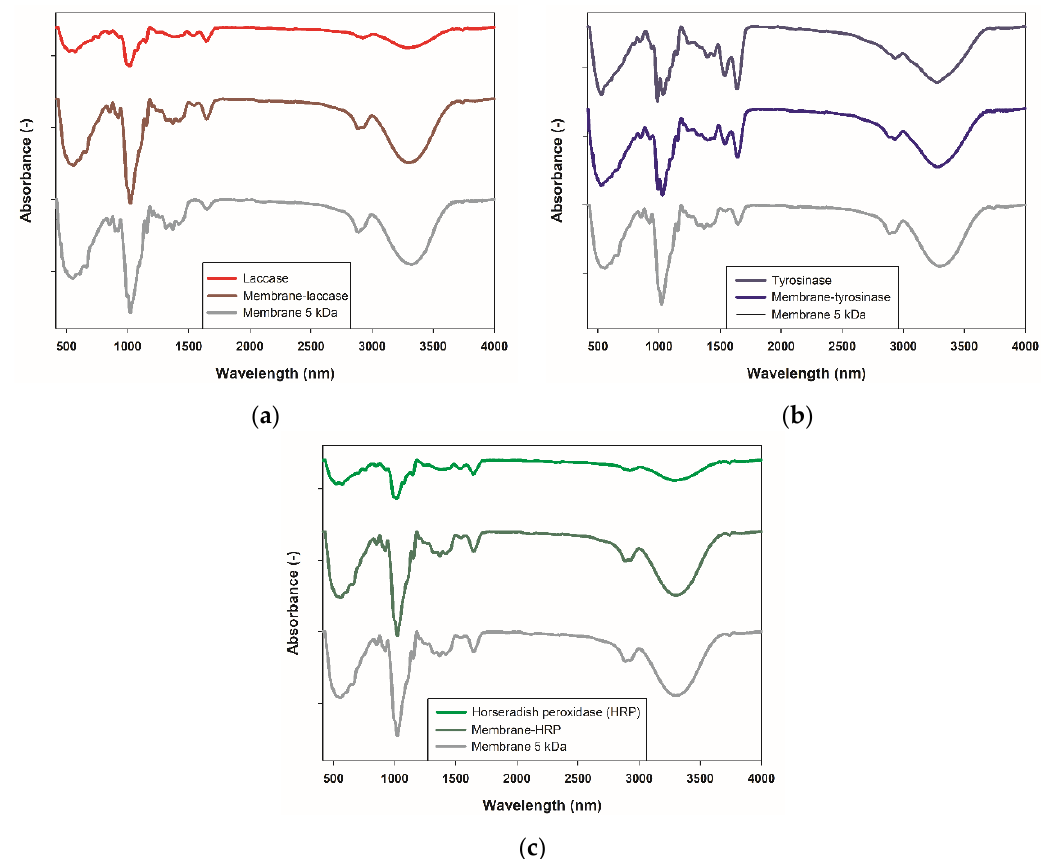
Figure 1. Fourier transform infrared spectra of the pristine cellulose membrane and ( a ) free laccase and membrane after laccase immobilization, ( b ) free tyrosinase and membrane after tyrosinase immobilization and ( c ) free horseradish peroxidase (HRP) and membrane after HRP immobilization. To deeper investigate the immobilization process, its yield, membrane loading, and